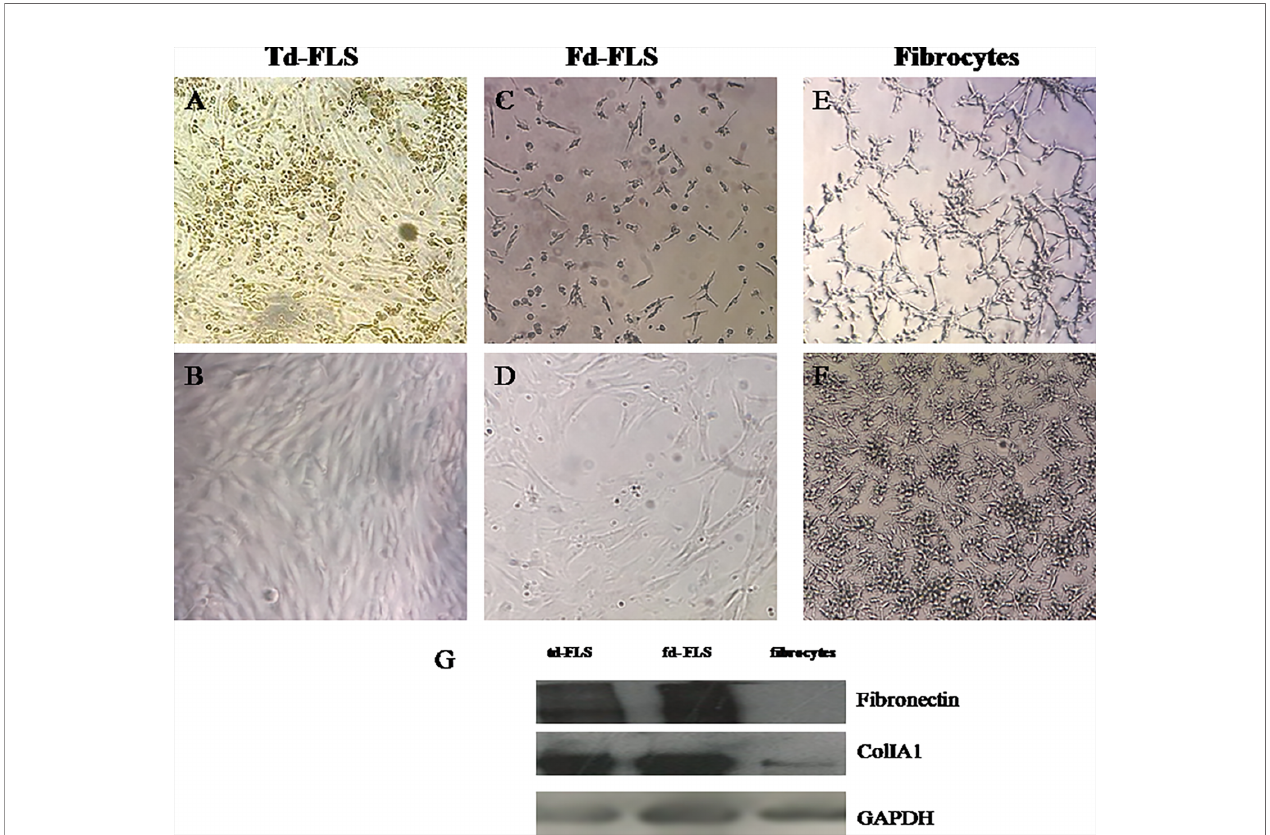
FIGURE 2 | Light microscopic features and mesenchymal marker expression in td-FLS, fd-FLS and fi brocytes from patients with RA: Spindle-shaped adherent cells started to appear in synovial fl uid cultures from patients with RA after few days of culture (C) . Third passage fd-FLS showed a spindle-shaped appearance (D) similar to RA td-FLS (A, B) . Fibrocytes from PBMC of patients with RA displayed some features of td-FLS, such as a fi broblast-like morphology. Fibrocytes showed cytoplasmic projections and a slim bipolar-shape (E, F) (original magni fi cation ×100). Western blot analysis showed fi bronectin, ColIA1 and GAPDH expression in fd-FLS, td-FLS and fi brocytes from patients with RA (G) . The Western blots are representative of one experiment out of